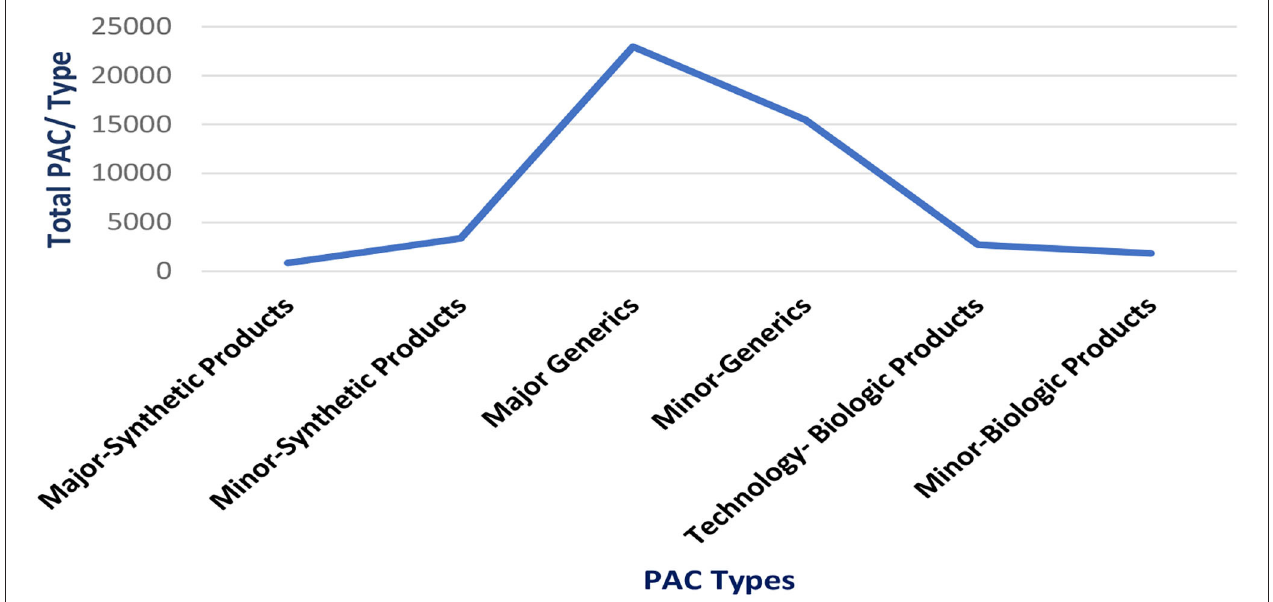
FIGURE 1 | Post-approval changes processed in Brazil (2016 −